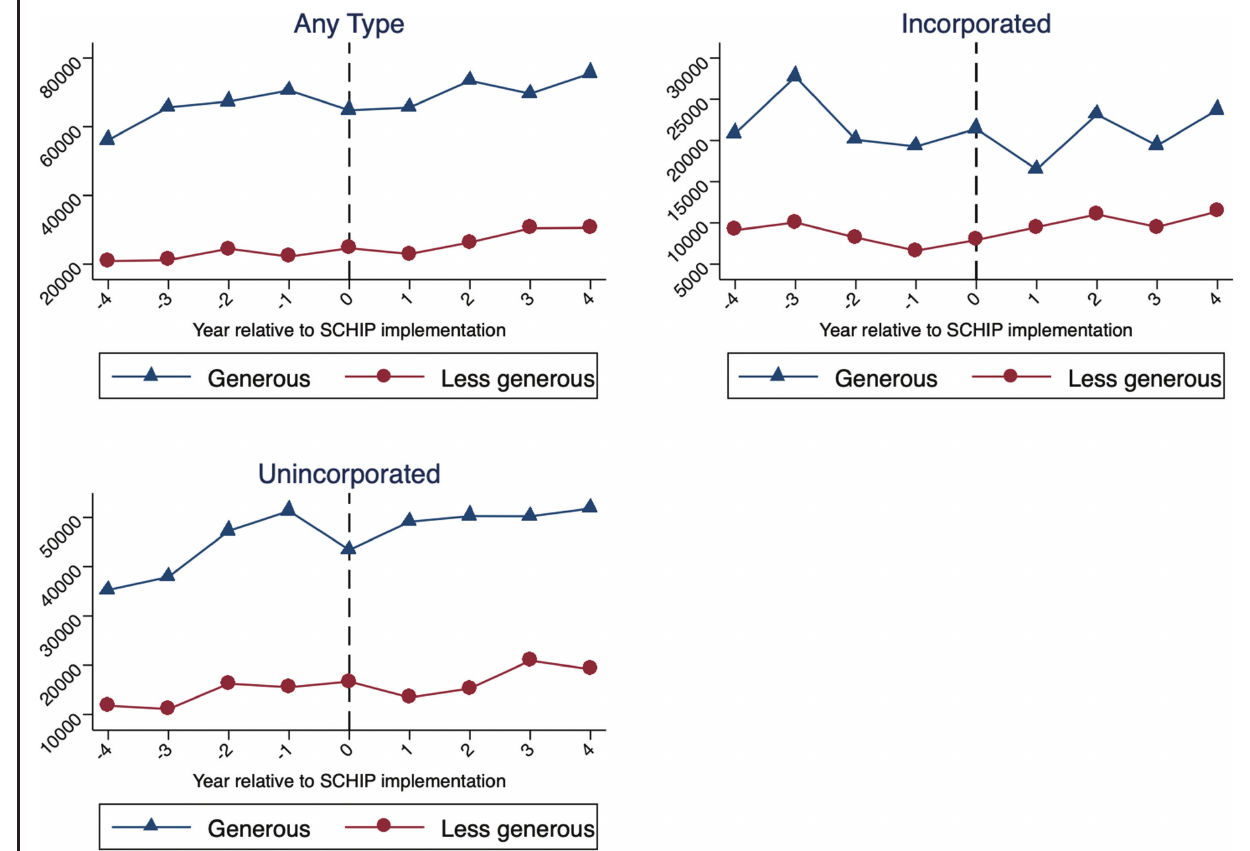
Figure 1 Pre and Post Policy Trends in the Supply of Immigrant